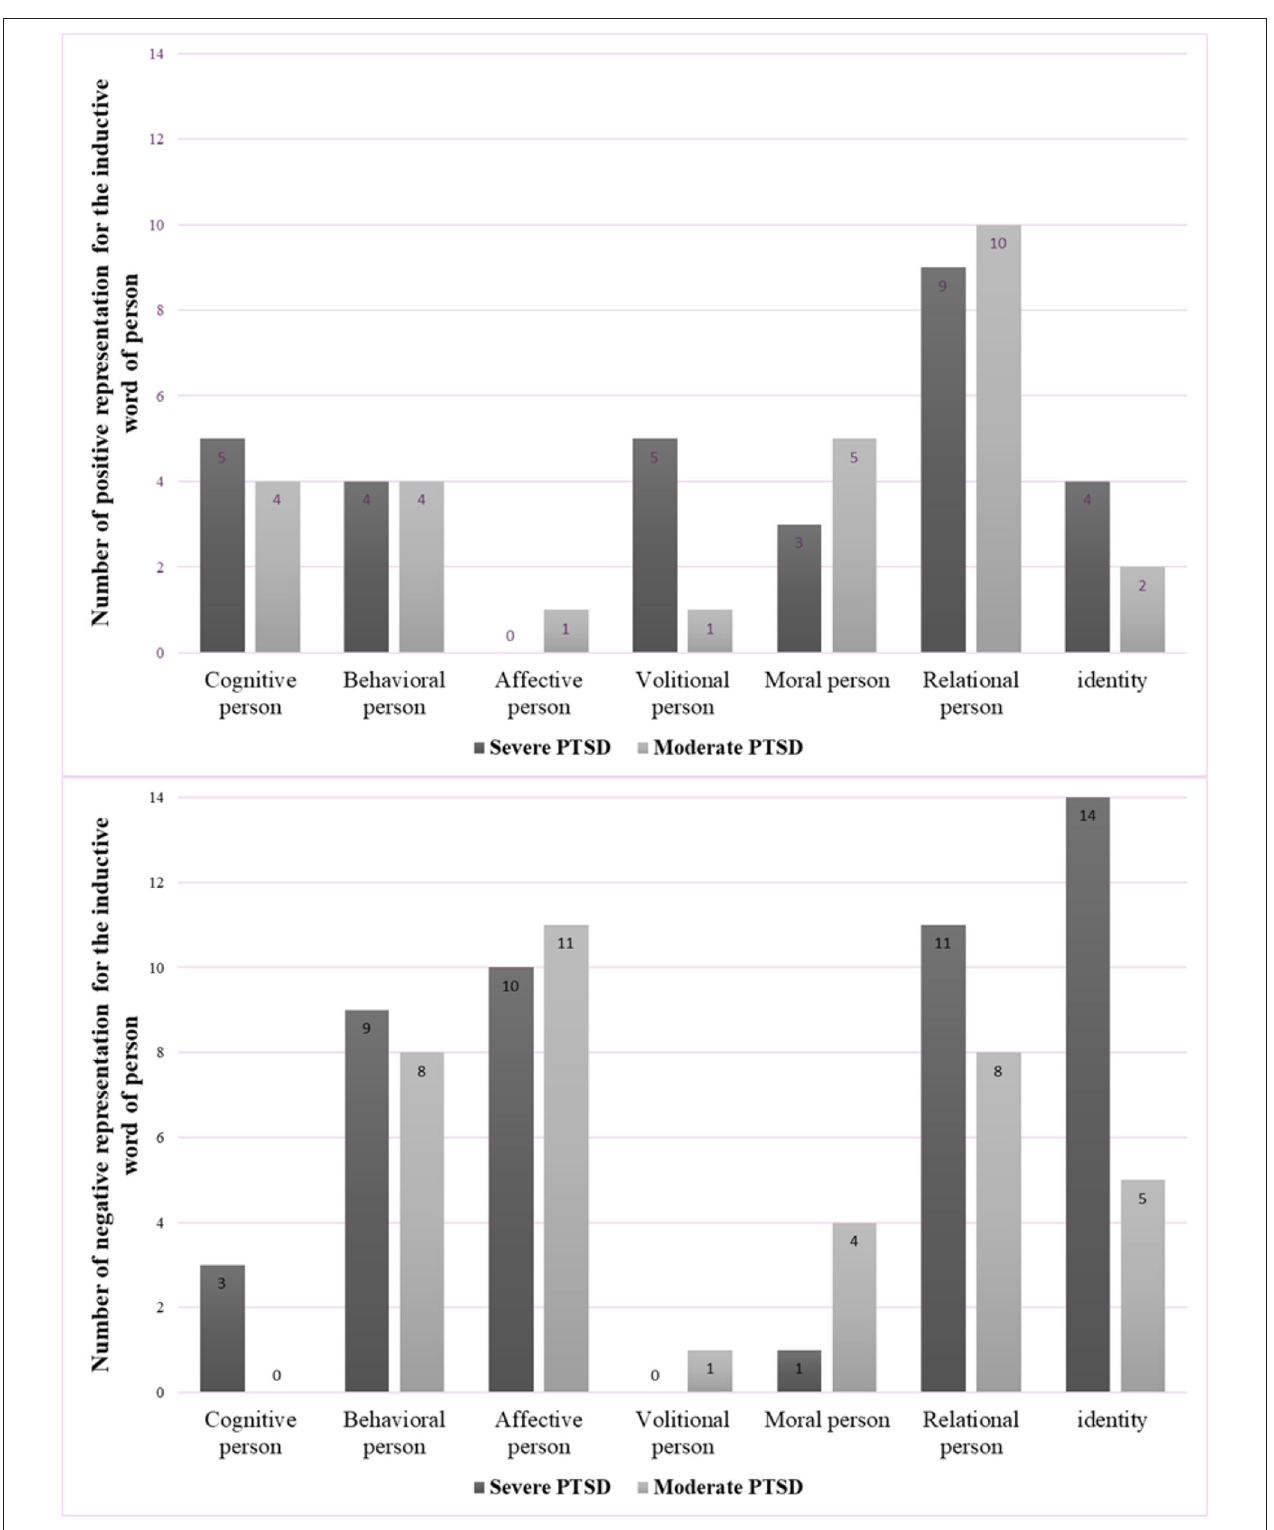
FIGURE 1 | Categories and numbers of positive (top) and negative (bottom) words referring to the person for severe and moderate PTSD groups.